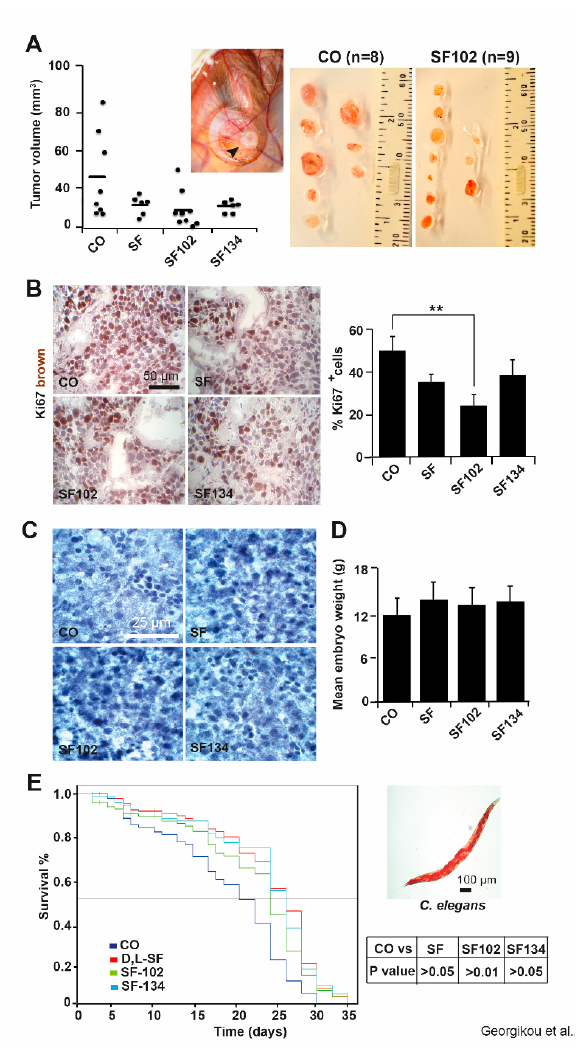
Figure 5. SF102 and SF134 inhibit tumor xenograft growth without obvious side effects. ( A ) BxPc-3 cells were seeded onto the CAM of fertilized chicken eggs on day 9 of embryonal development. Sulforaphane (SF, n = 6), SF102 (n = 9), or SF134 (n = 6), 10 µM each, were injected in 50 µl PBS into the CAM vessels on day 14 of development. The tumor xenografts were resected on day 18, and the tumor volumes were calculated as described in the Methods part. The control (CO, n = 8) group refers to xenografts that have received a PBS injection only. A representative image of a xenograft on the CAM (black arrow) on day 18 is shown. The volumes of individual tumors (black dots) and the mean tumor volumes of each experimental group (black lines) are shown. Statistical significance according to Bonferroni-Holm correction for multiple tests was not obtained and the single P values were: P = 0.646 for CO versus SF; P = 0.098 for CO versus SF102 ; P = 0.649 for CO versus SF134 . ( B ) Frozen xenograft tissue sections were stained with the proliferation marker Ki67 (brown), and representative immunofluorescence pictures are shown on the left under 400× magnification. The scale bar indicates 50 µm. The intensity of the Ki67 immunofluorescence signal was quantified in 10 randomly chosen vision fields using ImageJ and the means ±SD are shown in the diagram on the right. ** p < 0.01. ( C ) Hematoxylin staining of embryonal liver sections of embryos derived from fertilized chicken eggs, which were treated as described above. The scale bar indicates 25 µ m. ( D ) The mean embryonal weight of the chick embryos was determined by weighting—the means of 15 embryos per group ± SD are shown. ( E ) Wild type C. elegans nematodes were treated with sulforaphane (SF), SF102 , or SF134 for 48 h, or were left untreated (CO) and Kaplan Meier analysis was performed. A representative microscopy image from a C. elegans worm is shown on the right. The scale bar indicates 100 µ